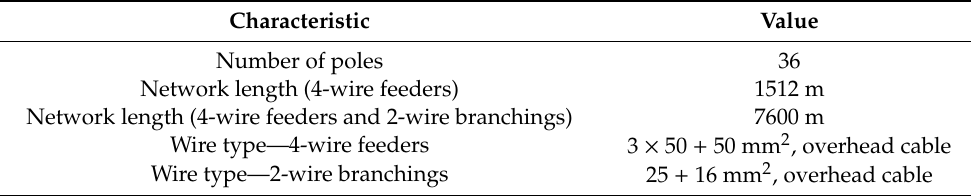
Table 4. The main characteristics of the LV network used in the case study.